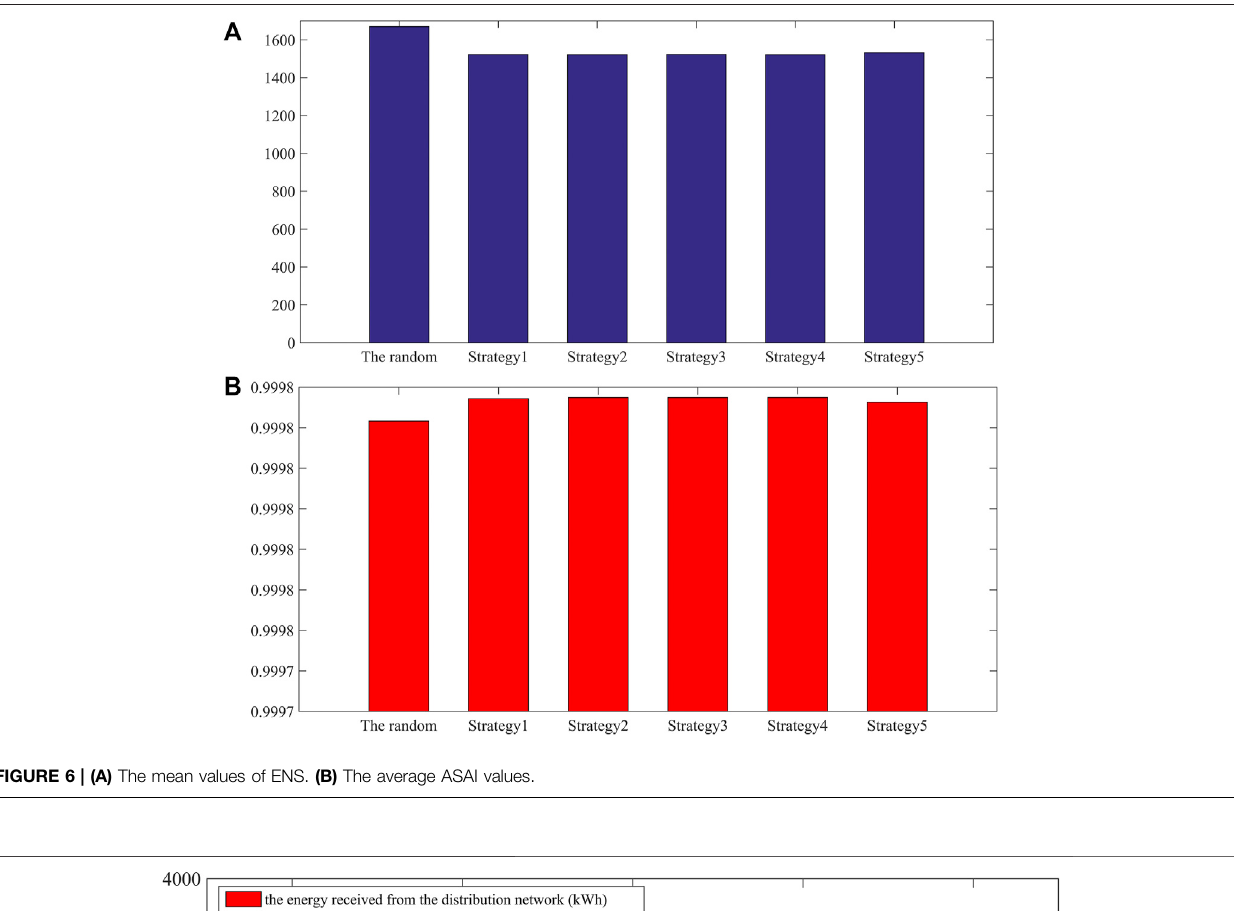
FIGURE 6 | (A) The mean values of ENS. (B) The average ASAI values.